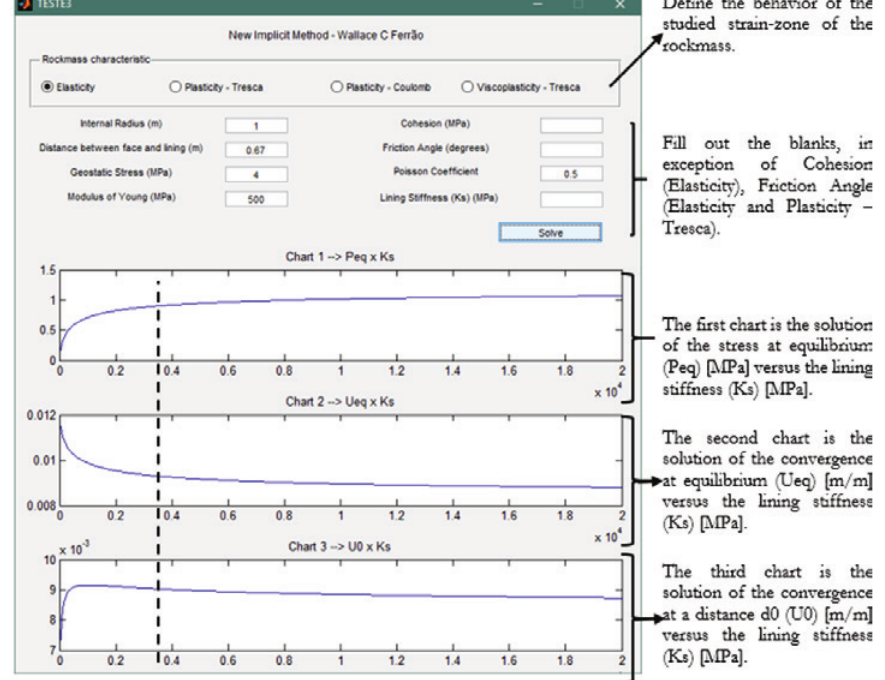
Solution for an elastic rockmass using .gui